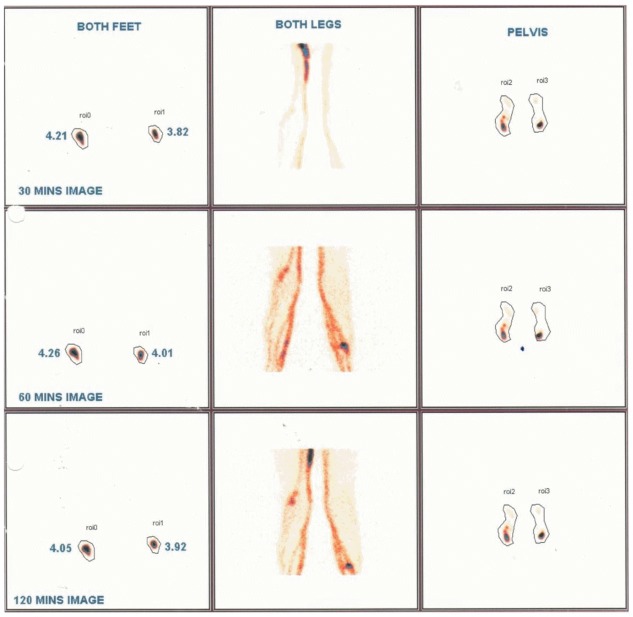
Baseline 30, 60 & 120 minute images showing lymphatic pathology in left leg of a 11 year old male (symptomatic & Mf positive).In right leg, the lymphatic channel well visualized, and tracer uptake at injection site is low indicating lymphatic flow obstruction in left leg. There is also some delay in uptake in the left leg, and both legs have evidence of lateral channel formation.